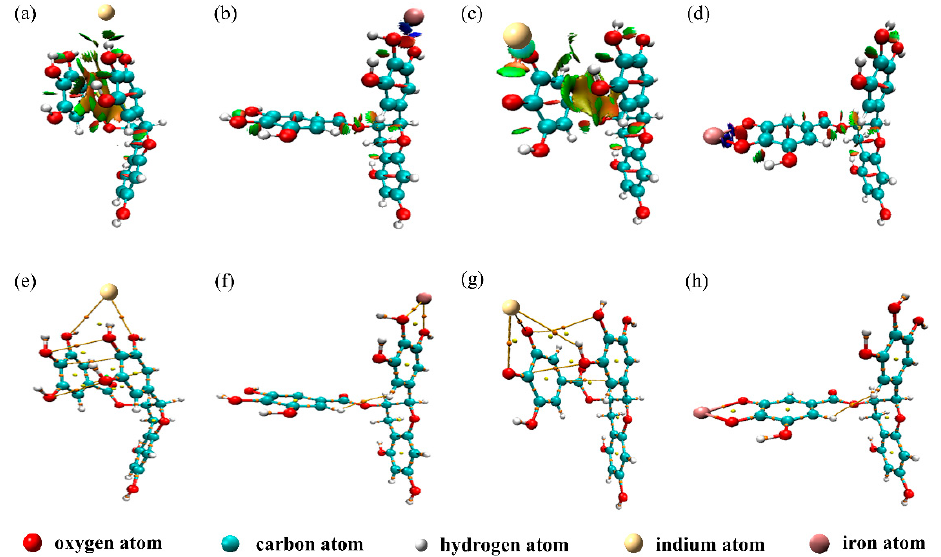
Figure 3. RDG function isosurface map of EGCG–metal composites: ( a ) B-EGCG–In(III), ( b ) B-EGCG–Fe(III), ( c ) D(-2H)-EGCG–In(III), and ( d ) D(-2H)-EGCG–Fe(III). AIM analysis profiles of EGCG–metal complexes: ( e ) B-EGCG–In(III), ( f ) B-EGCG–Fe(III), ( g ) D(-2H)-EGCG–In(III), and ( h ) D(-2H)-EGCG–Fe(III).